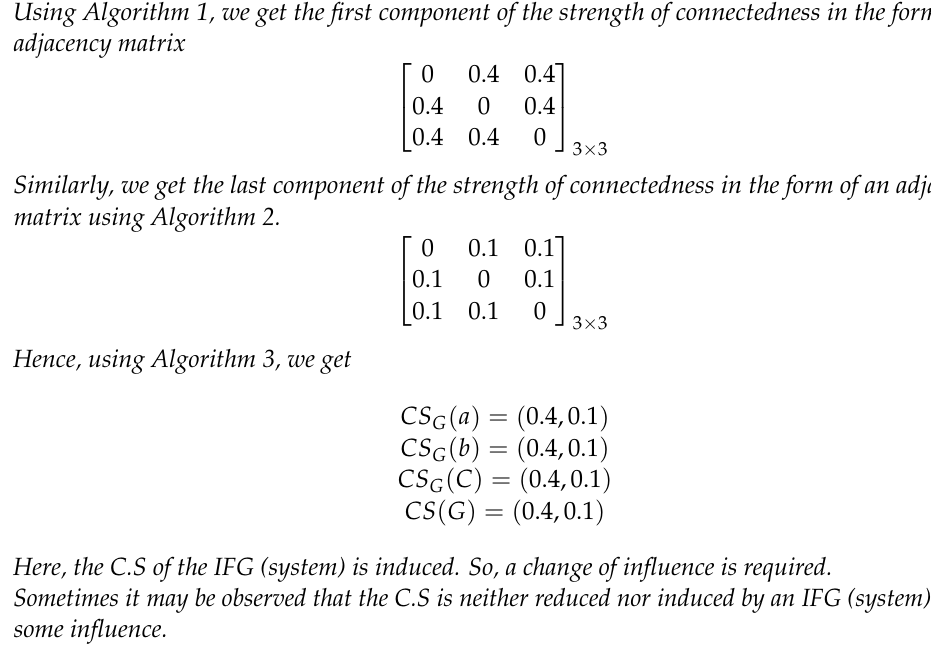
Figure 4. Intuitionistic fuzzy graph.